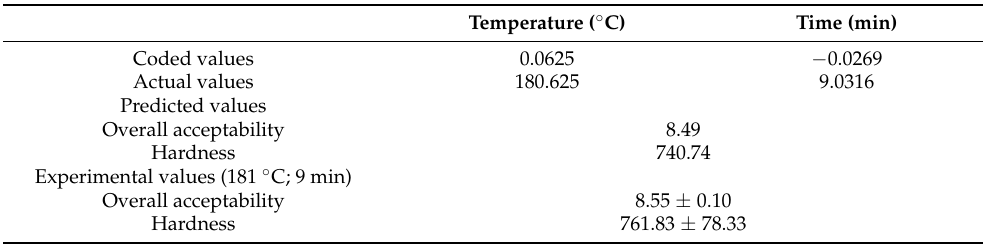
Table 5. Optimal temperature and time for heating braised mackerel with radish using the super- heated steam roaster.